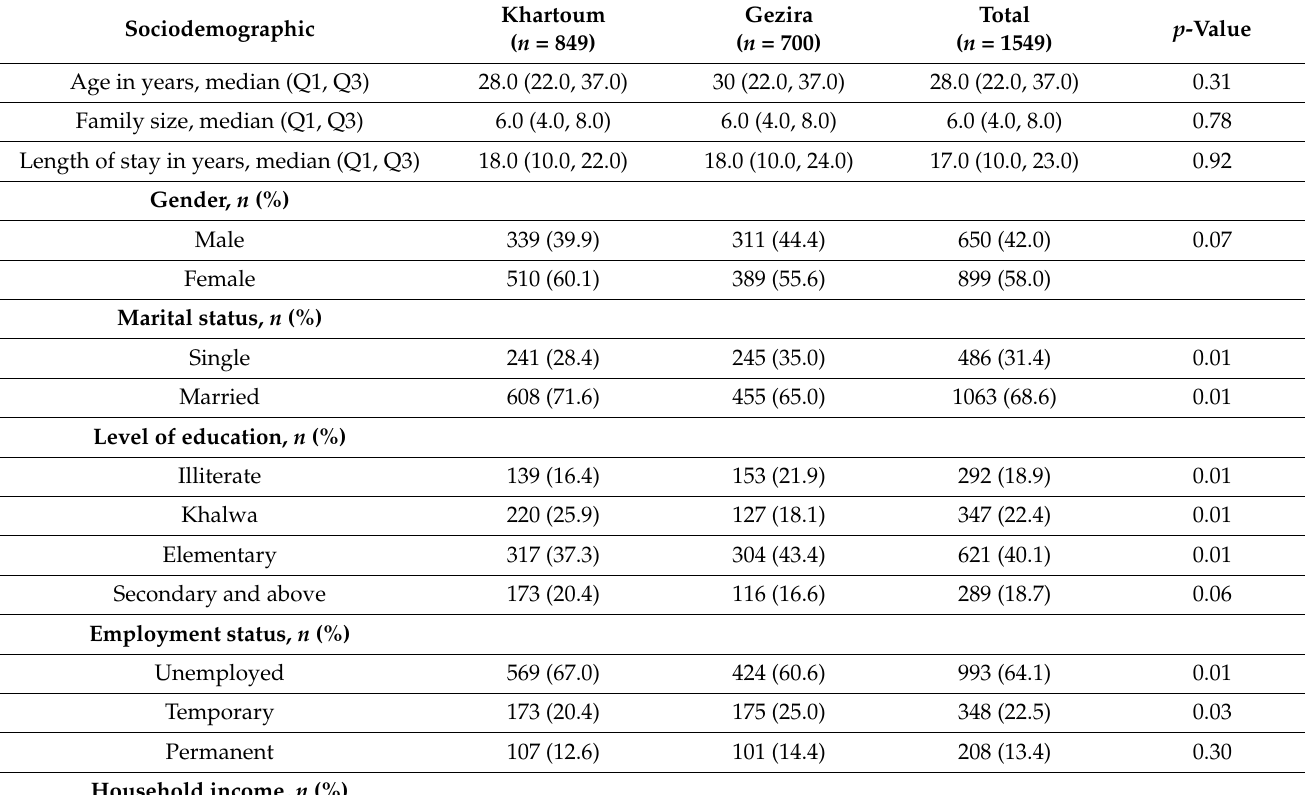
Table 1. Sociodemographic characteristics of 1549 IDPs at baseline (phase 1) by place of residence.